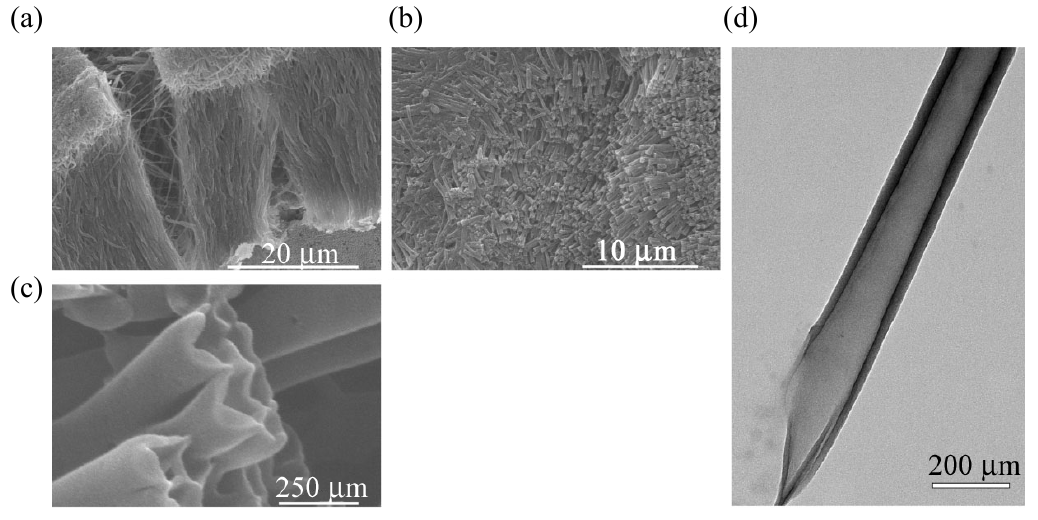
Figure 37. I–V characteristics of (a) nanotube arrays and (b) a single nanotube. The